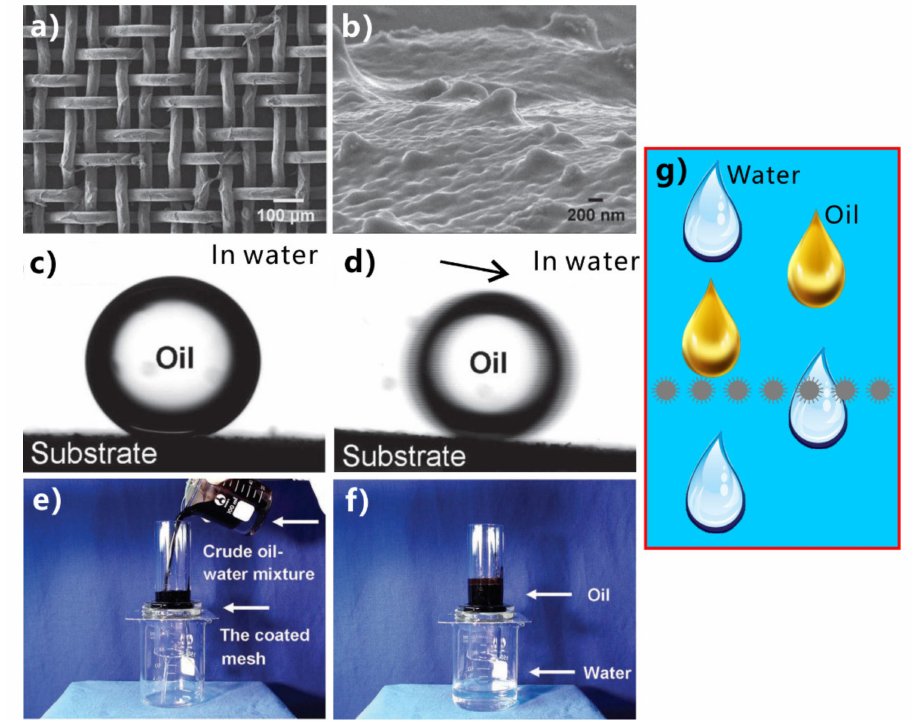
Figure 14. Separating the mixture of oil and water by the underwater superoleophobic stainless-steel mesh coated with hydrogel. ( a , b ) Surface morphology of the hydrogel-coated mesh. ( c ) A drop of oil on the hydrogel-coated mesh in water. ( d ) Rolling of an underwater oil droplet on the resultant mesh. ( e , f ) Separation of the mixture of crude oil and water by the prewetted mesh: ( e ) pouring the mixture onto the separation mesh and ( f ) after separation. ( g ) Schematic diagram of the separation mechanism based on the superhydrophilic and underwater superoleophobic porous mesh. Reprinted with permission from ref. [62]. Copyright 2011, WILEY-VCH Verlag GmbH & Co.